Question: Compose a caption that would accompany this figure in a paper.
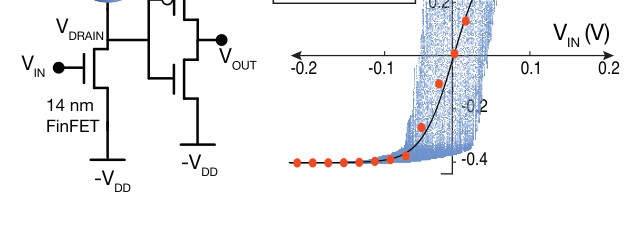
Answer: 3T/1MTJ p-bit circuit with double-SAF-free MTJ (a) We use the full circuit model described in FIG. 2in conjunction with a 14 nm HP-FinFET predictive model [65], simulated in HSPICE. Magnet diameters are 25 nm and thick- nesses are 1 nm. The diameter is chosen to match transistor resistance. (b) The blue trace is observed by observing VOUT as a function of VIN while VIN is linearly swept from −0.2 V to 0.2 V in a 250 ns time-window. The red dots are obtained as separate measurements where VIN is fixed to a given value and a time-average of the output over 5 µs is taken with a 1 ps time step. The black line is a tanh fit to this average.